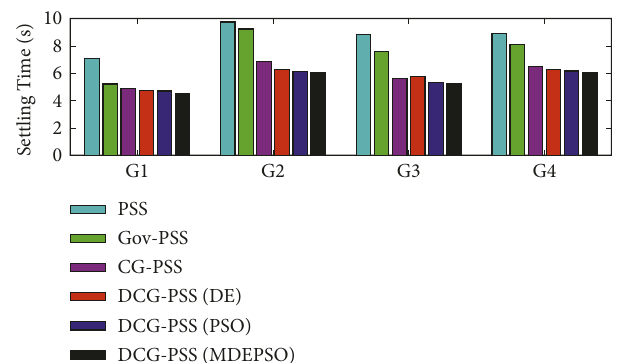
14 , ω 41 , ω 23 and ω 32 .